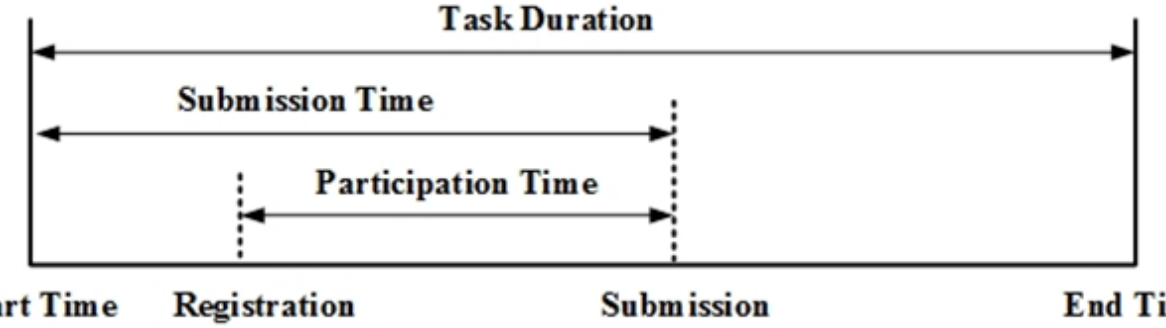
Figure 3. Stage division of the crowdsourcing contest for solvers. Source: this figure was created by the